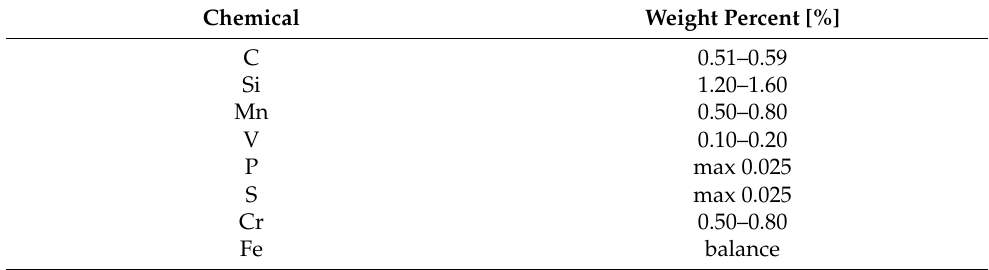
Figure 3. Tested material samples: ( a ) very fine martensitic material structure; ( b ) etched with Nital 2%. Table 1. Chemical composition of the steel according to the standard CSN EN 10089-03.